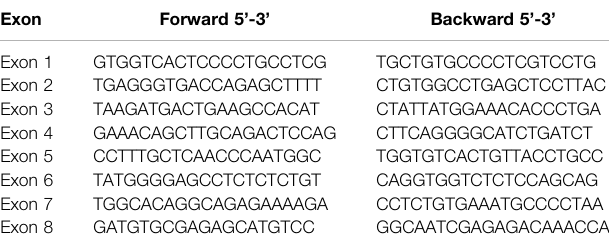
TABLE 1 | Primers for F10 ampli fi cation.